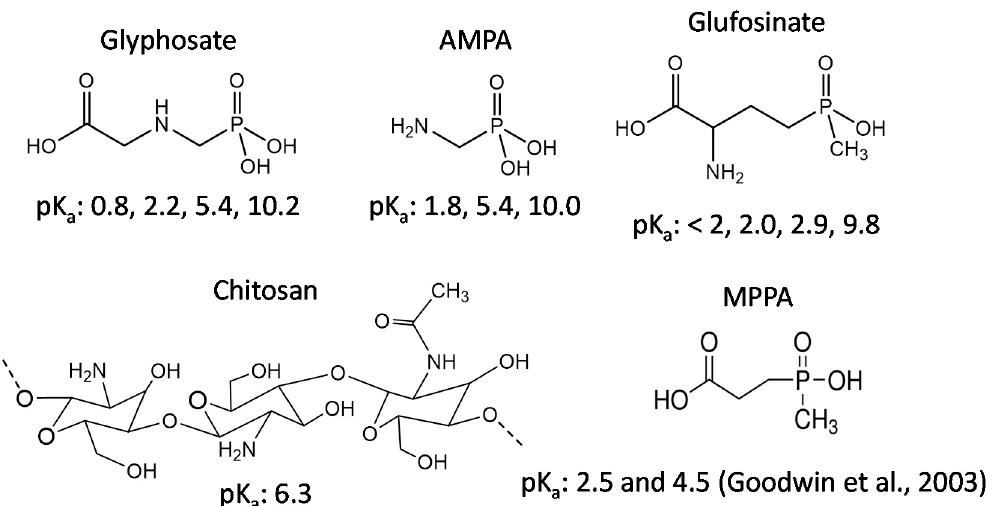
Figure 1. Structures and pK a of glyphosate, chitosan (CS), and other studied compounds (molar mass of glyphosate: 169.07 g/mol; aminomethylphosphonic acid (AMPA): 111.04 g/mol; glufosinate: 181.13 g/mol; 3-methyl-phosphinico-propionic acid (MPPA): 152.09 g/mol) [40].